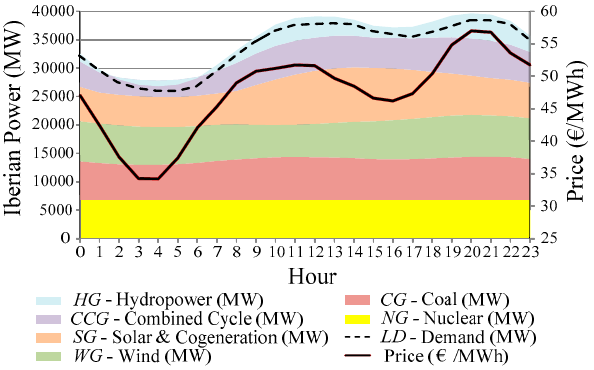
Figure 4. Hourly average power generations, power demand and price in year 2012.